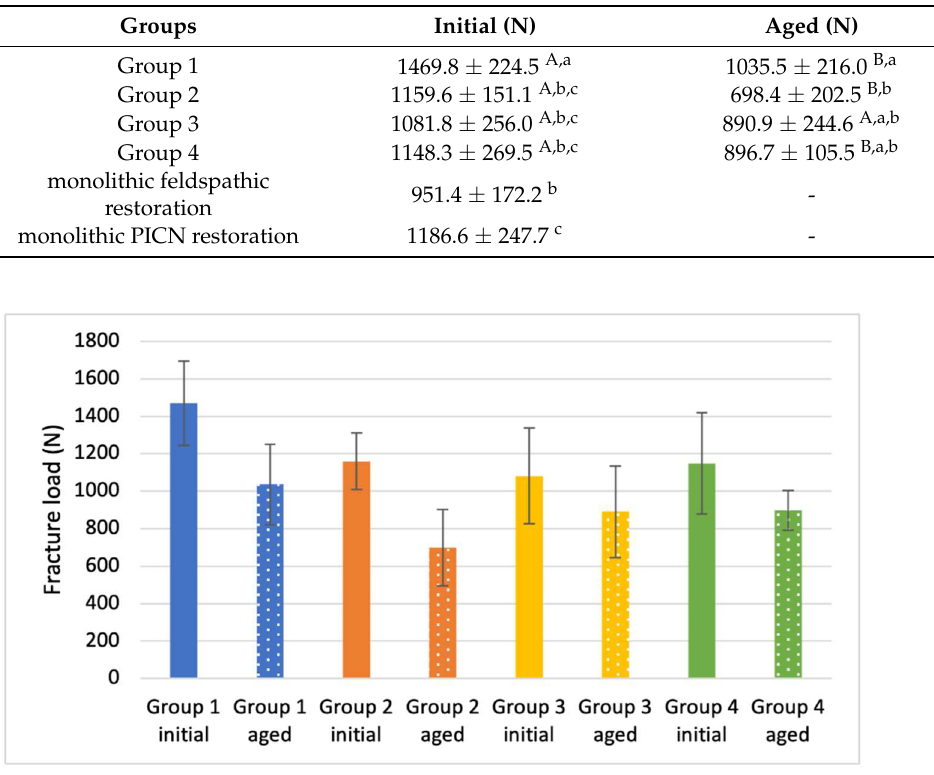
Figure 5. Fracture load values of the restorations ( n = 8 per group). Table 3. Fracture load means and standard deviations. Statistically significant differences between groups determined with Fisher-LSD post-hoc test are indicated with varying superscript letters ( p > 0.05) (upper case horizontal, lower case vertical).